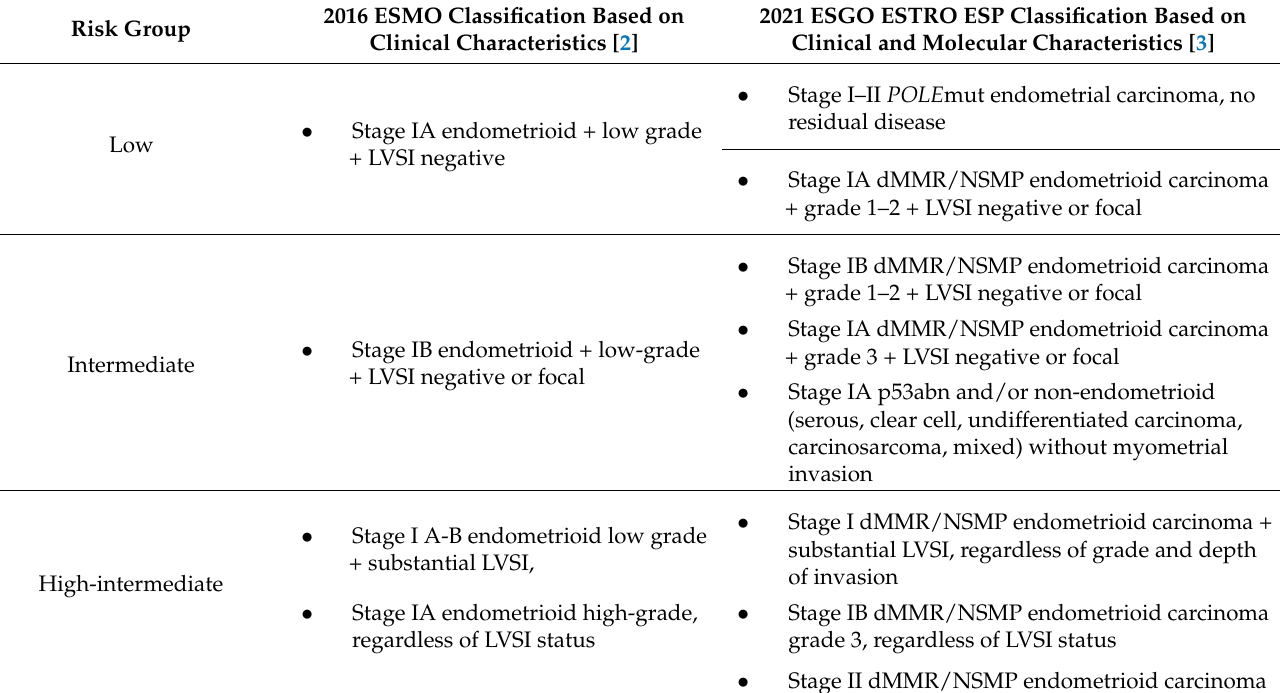
Table 1. New risk groups to guide adjuvant therapy